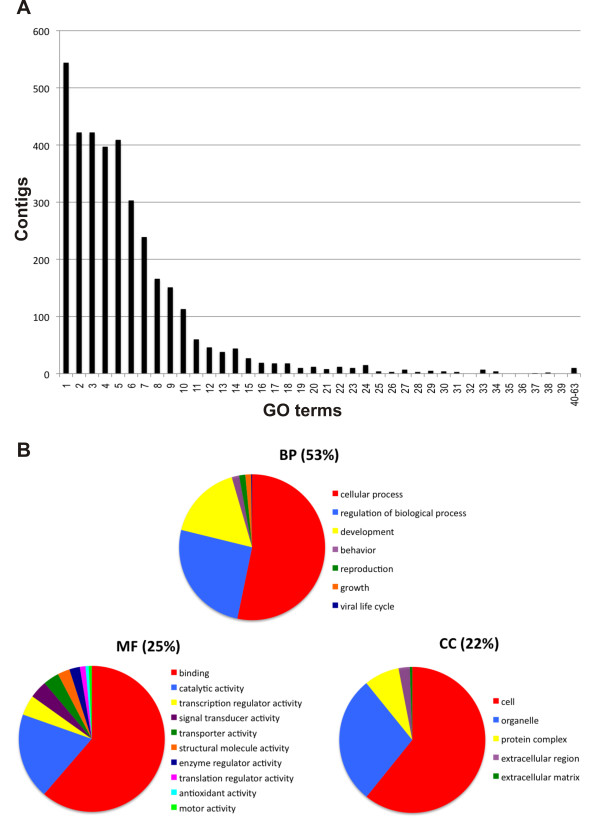
Functional annotation. Panel A reports the number of transcripts annotated with numbers of GO terms per transcripts. Panel B shows European eel contigs GO terms representation for biological process (BP), molecular function (MF) and cellular component (CC) ontologies, calculated after mapping by single count 122,193 GO terms to a total of 124 GO-Slim ancestor terms.